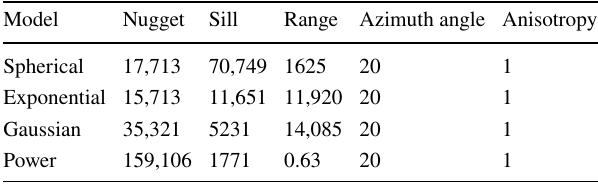
Table 2 Optimal value of parameters for different variogram